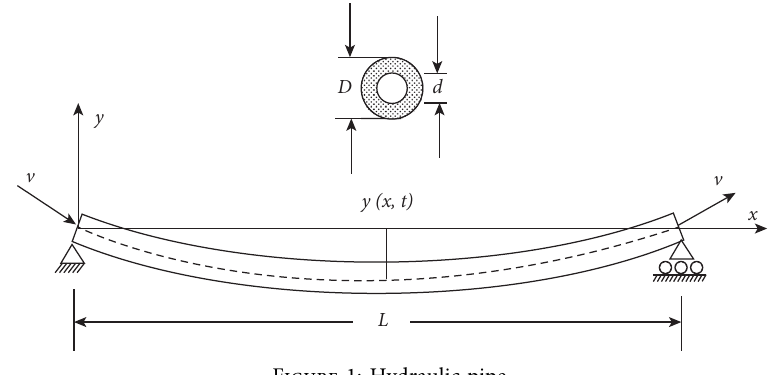
Figure 1: Hydraulic